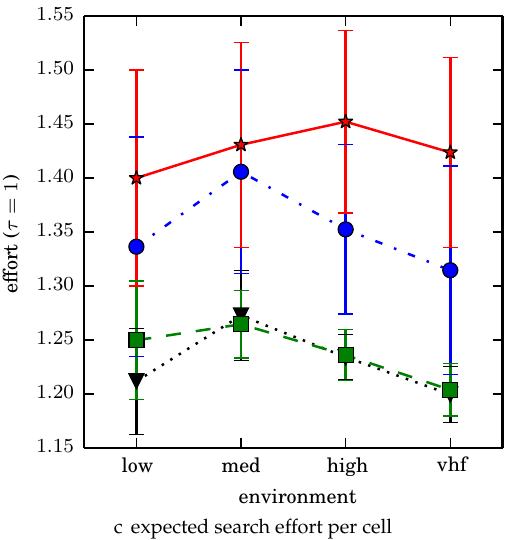
Figure 21. Results for Experiment 3 in nonuniform environment. See Table 3 for more detailed figures.